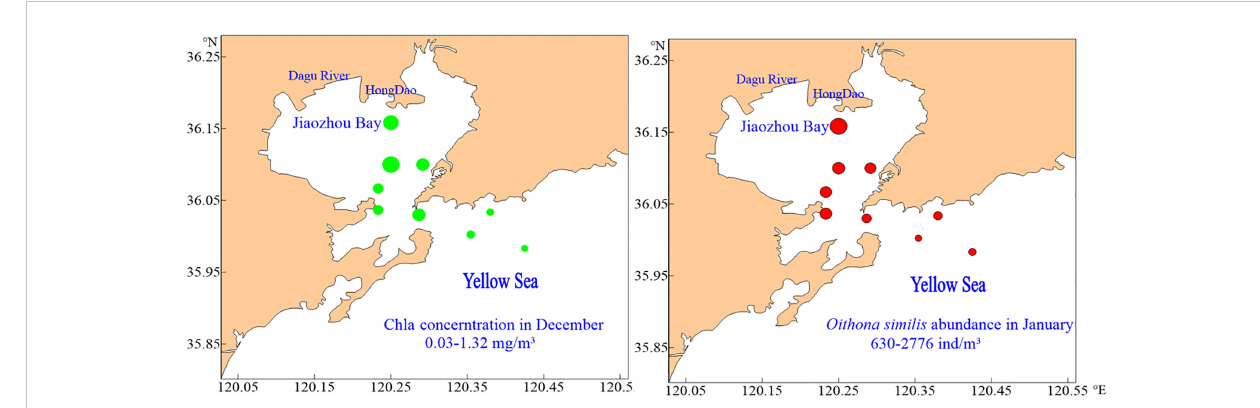
FIGURE 4 The spatial distribution of CHL a concentration and Oithona similis abundance in December and January in Jiaozhou